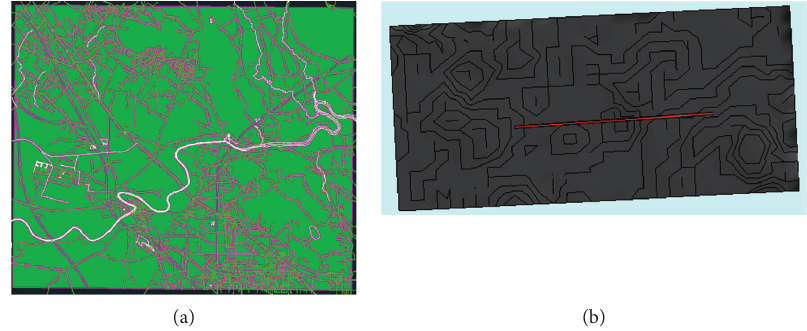
Figure 5: (a) Civil 3D Surface. (b) Topography surface and layout of the road section boundary in Revit.